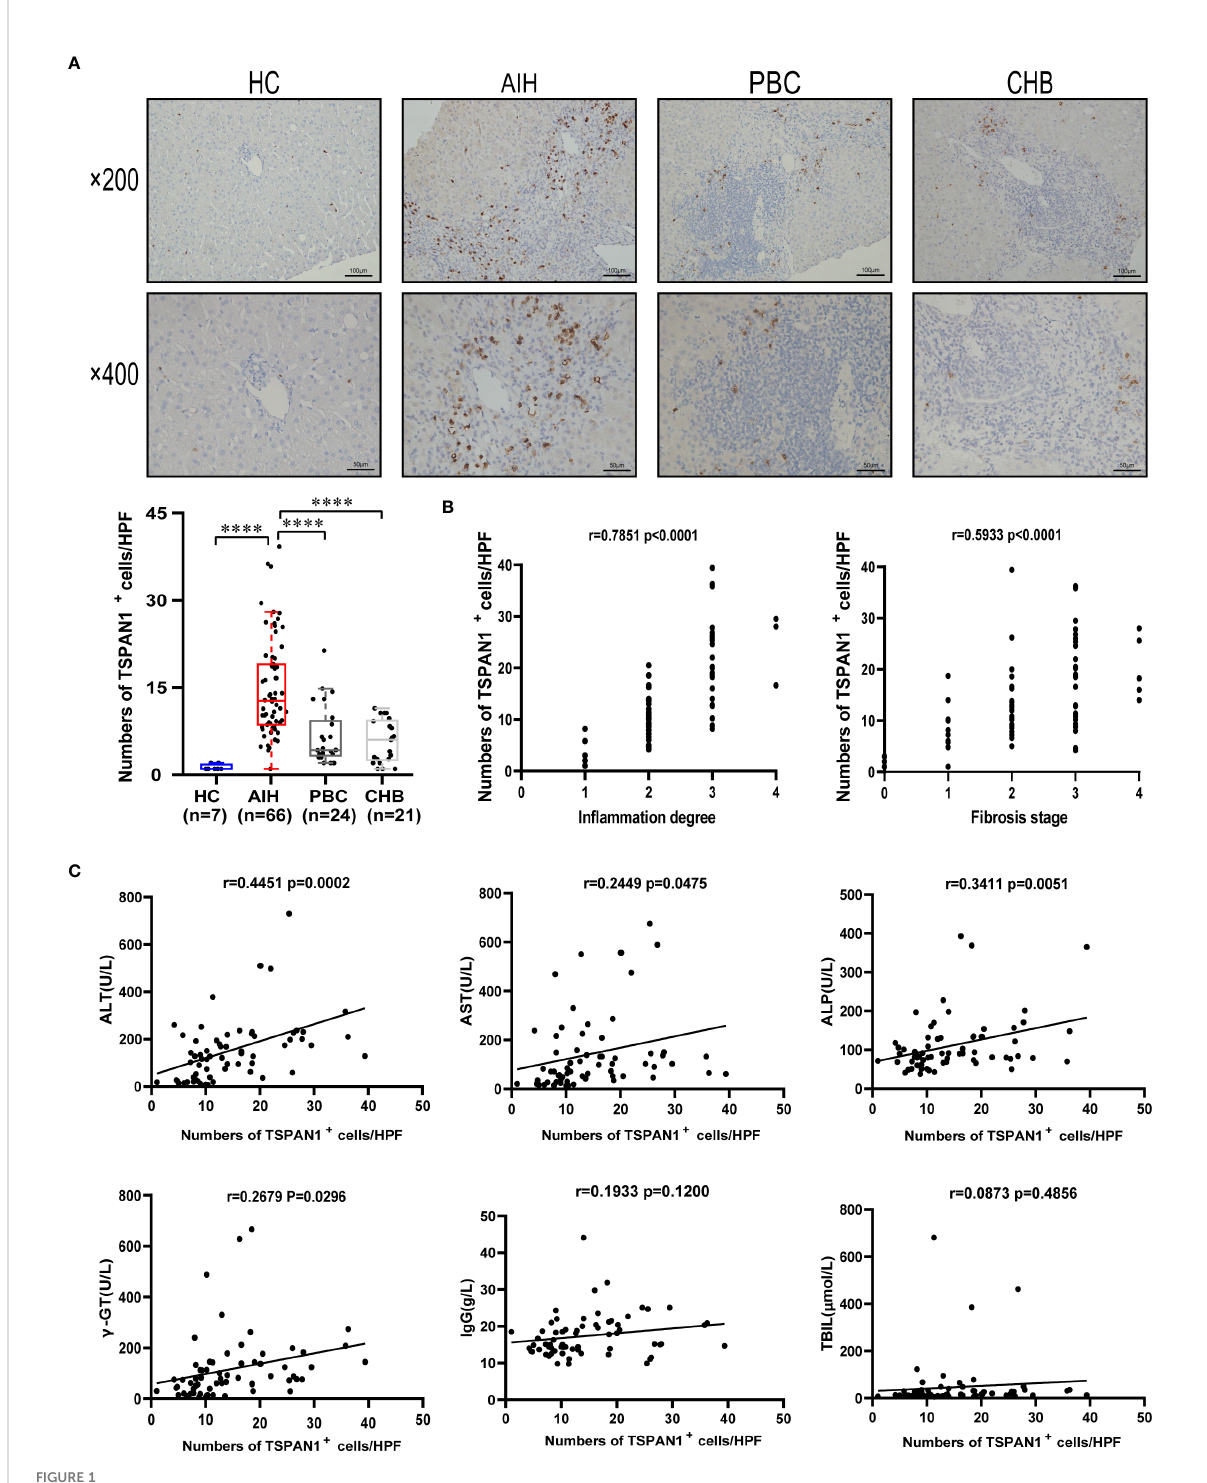
FIGURE 1 TSPAN1 expression was increased in AIH. (A) Representative immunohistochemical staining of TSPAN1 in AIH, PBC, CHB, and healthy controls (HCs). (B) The correlation analysis of the numbers of TSPAN1 + cells in liver tissues of AIH with hepatic in fl ammation degree and fi brosis stage (×400). (C) The correlation analysis of the numbers of TSPAN1 + cells in liver tissues of AIH with ALT, AST, ALP, g GT, IgG, and TBIL levels. **** P <